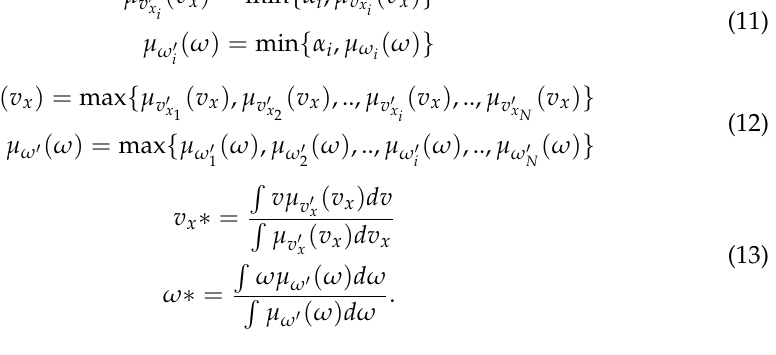
Table 3. Rule base of the